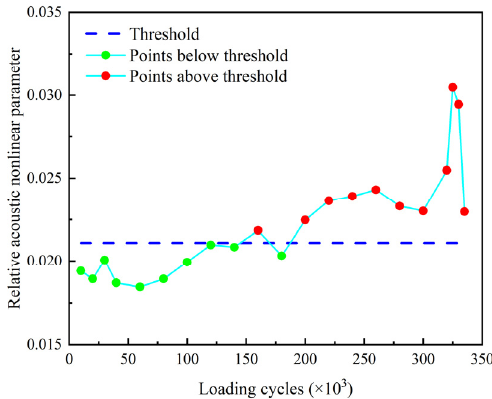
Figure 33. Relative acoustic nonlinear parameter 𝛽 (cid:4593) versus loading cycles corresponding to 10-cycle excitation signa